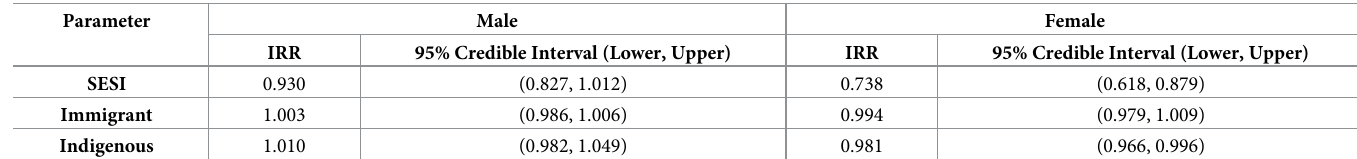
Table 4. Incidence Risk Ratio (IRR) and 95% credible interval for cardia GC dataset stratified by sex using spatial Poisson regression model. Parameter